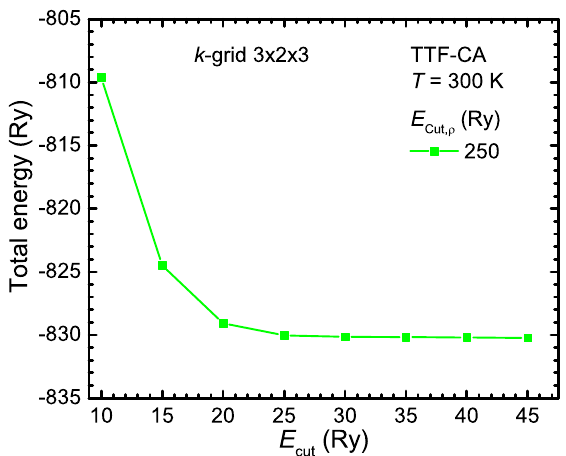
Figure B1. Total energy of TTF-CA at 300 K for a 3 × 2 × 3 k -grid for an electron density cutoff energy of E cut, ρ = 250 Ry as a function of E cut . Above E cut = 25 Ry, the total energy varies